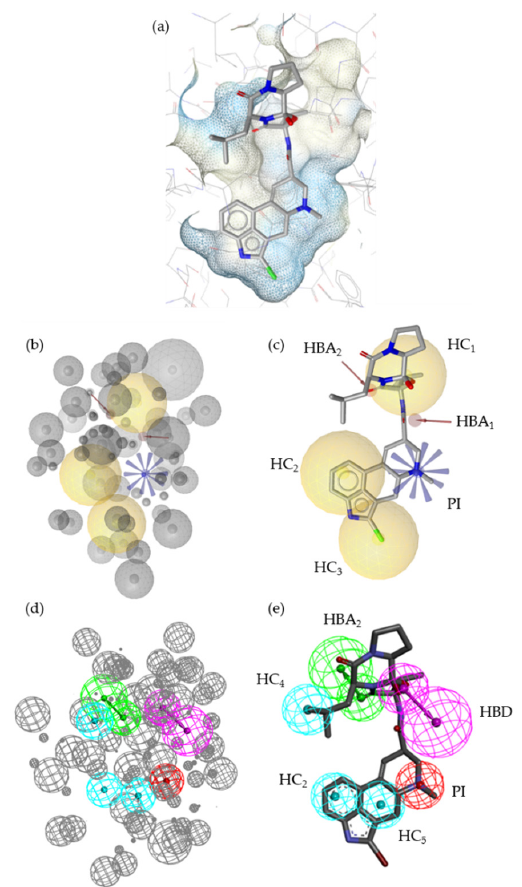
Figure 4. SB pharmacophore models M1 and M2 generated using LS and DS, respectively. M1 and M2 are based on the cryo-EM structure of D 2 R in complex with agonist 2 (PDB ID 7jvr [23]). ( a ) Agonist 2 in the ligand-binding pocket of D 2 R. ( b ) M1 including 60 exclusion volumes (XVOLs). ( c ) M1 aligned with 2 . ( d ) M2 including 113 XVOLs. ( e ) M2 aligned with 2 . XVOLs (grey). Hydrophobic contacts (HCs; yellow and cyan spheres). Hydrogen bond acceptor (HBA; red arrows, green spheres). Hydrogen bond donor (HBD; purple sphere). Positively ionizable interaction (PI; blue star-like shape, red sphere). All features represent characteristics of the respective structural features of the investigated